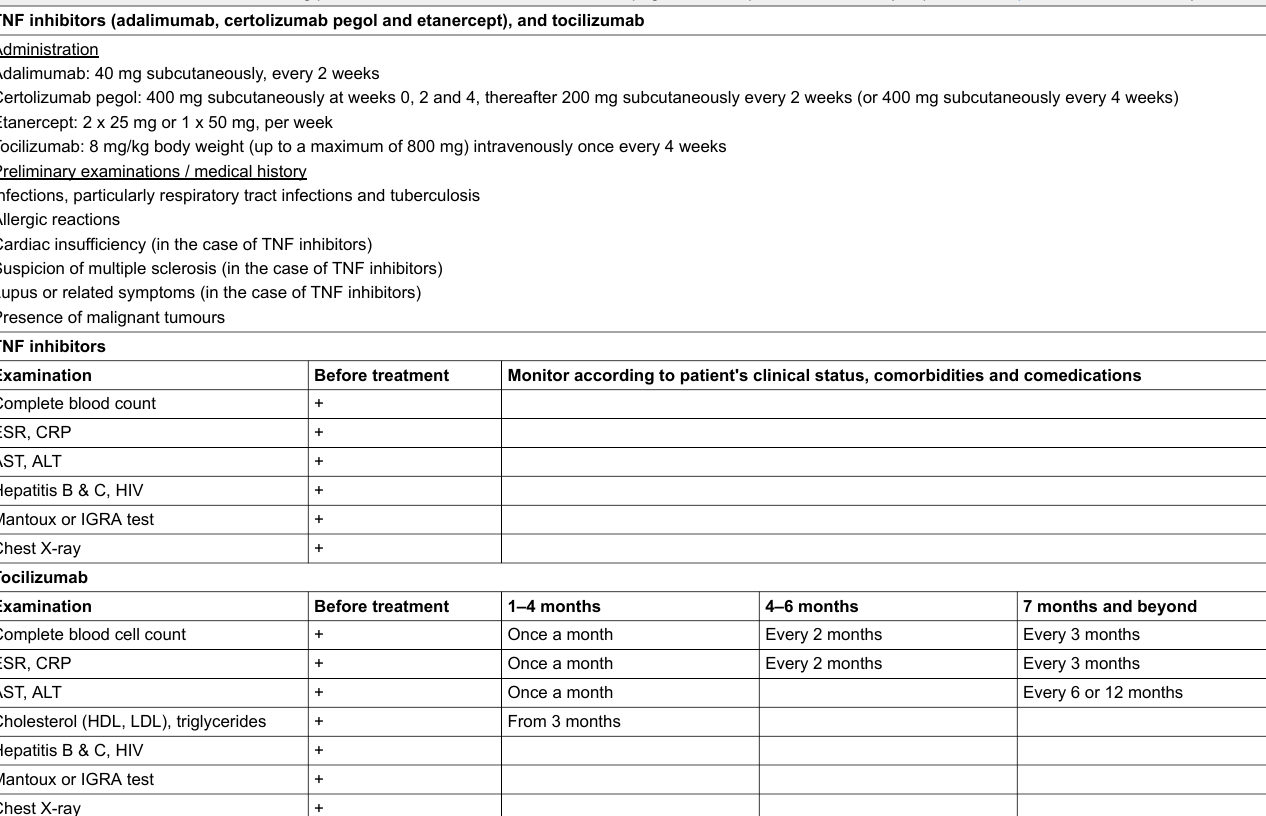
Table 2: Recommended clinical monitoring procedures for adalimumab, certolizumab pegol, etanercept and tocilizumab (adapted from http://www.rheuma-net.ch). TNF inhibitors (adalimumab, certolizumab pegol and etanercept), and tocilizumab Administration Adalimumab: 40 mg subcutaneously, every 2 weeks Certolizumab pegol: 400 mg subcutaneously at weeks 0, 2 and 4, thereafter 200 mg subcutaneously every 2 weeks (or 400 mg subcutaneously every 4 weeks) Etanercept: 2 x 25 mg or 1 x 50 mg, per